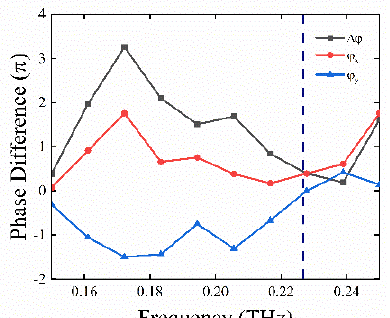
Figure 5. The simulated phase difference for U at a frequency ranging from 0.15 − 0.25 THz. The temperature is T = 300 K.